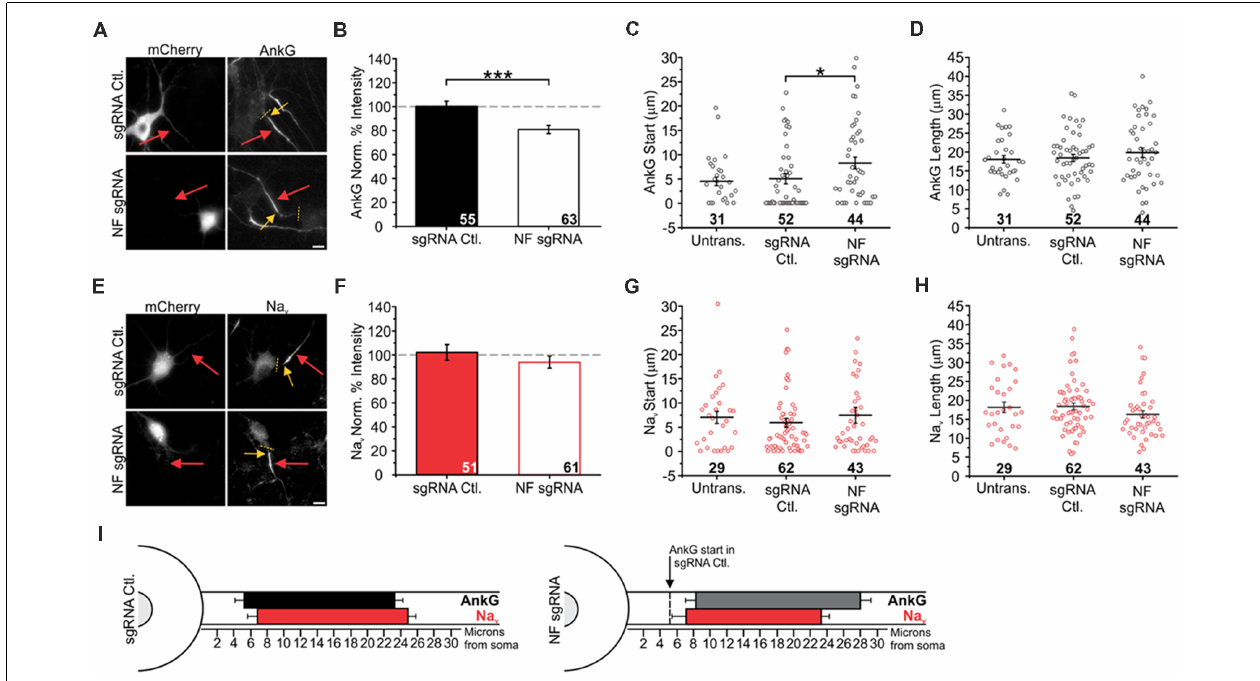
FIGURE 4 | Knockout of NF disrupts AnkG enrichment and relative localization to Na v . (A,E) Representative images for sgRNA control or NF sgRNA stained for mCherry with AnkG (A) or panNa v (E) . Red arrows indicate the AIS of transfected neurons; yellow arrows indicate start of enrichment; yellow dashed lines indicate junction of soma and axon. Scale bars: 10 µ m. (B,F) Ratio of mean fluorescence intensity for AnkG (B) and Na v (F) at the AIS in sgRNA control or NF sgRNA neurons normalized to adjacent untransfected neurons in the same image ( B : sgRNA Ctl. n = 55; NF sgRNA n = 63; ∗∗∗ p < 0.001, Student’s t -test. F : sgRNA Ctl. n = 51; NF sgRNA n = 61). (C,G) Distance from the soma to start of AIS enrichment for AnkG (C) and Na v (G) in untransfected, sgRNA control, and NF sgRNA neurons ( C : Untransfected n = 31; sgRNA Ctl. n = 52; NF sgRNA n = 44; ∗ p = 0.024, Kruskal-Wallis ANOVA followed by Dunn’s post-test with Bonferroni correction. G : Untransfected n = 29; sgRNA Ctl. n = 62; NF sgRNA n = 43). (D,H) AIS length for AnkG (D) and Na v (H) in untransfected, sgRNA control and NF sgRNA neurons ( D : Untransfected n = 31; sgRNA Ctl. n = 52; NF sgRNA n = 44. H : Untransfected n = 29; sgRNA Ctl. n = 62; NF sgRNA n = 43). Error bars indicate mean ± SEM. (I) To-scale distribution of AnkG (black) and Na v (red) in sgRNA control (left) and NF sgRNA (right) neurons. Color saturation of bars are indicative of average labeling intensity of the population. Dashed black line indicates start of AnkG enrichment in sgRNA control. Left error bar indicates SEM for distance from the soma, right error bar indicates SEM for length; data taken from (B–D) and (F–H)